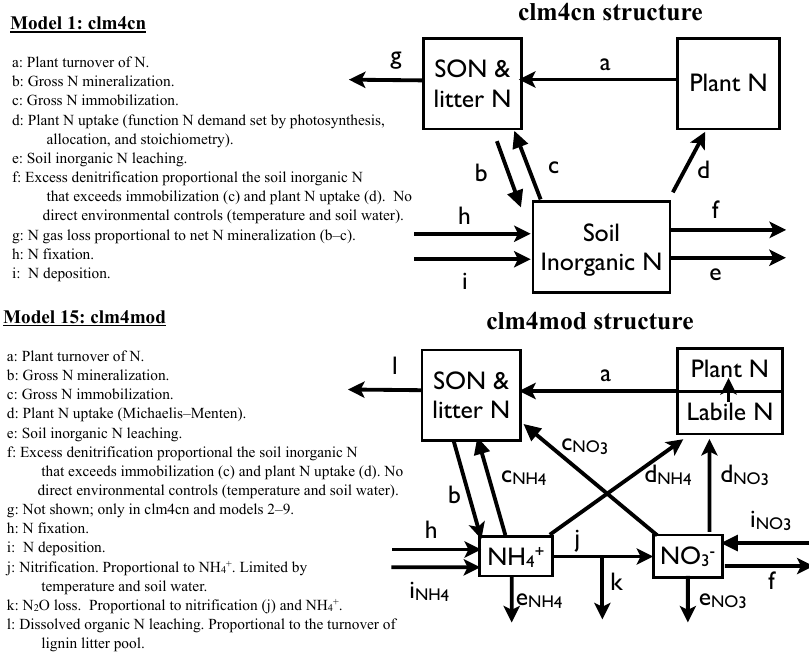
Fig. 1. Overview of the clm4cn and clm4mod model structure.